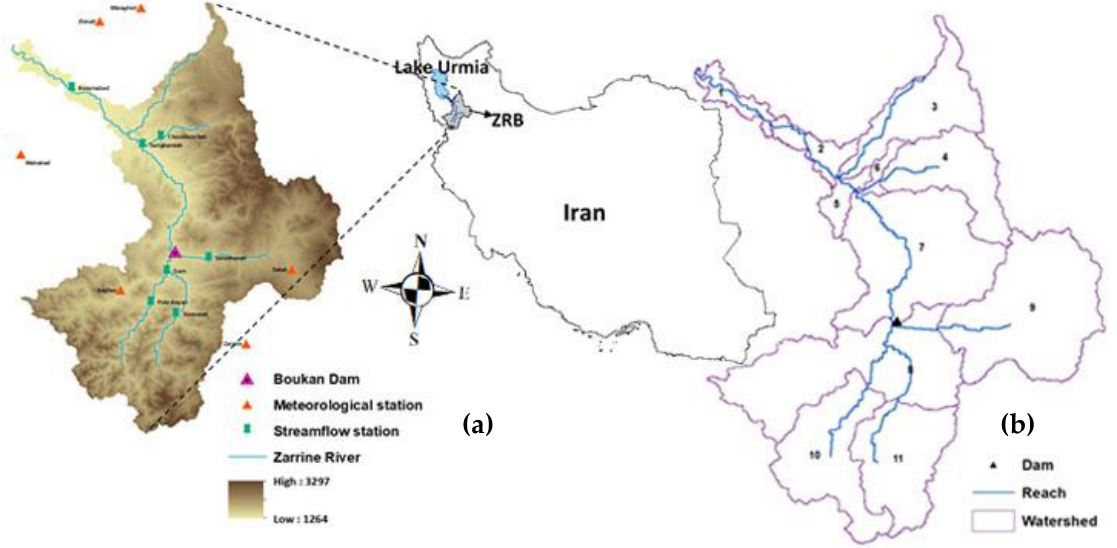
Figure 1. Map of the Zarrine River basin (ZRB) in northwestern Iran with the Boukan Dam and the climate and streamflow stations ( a ), together with the basin configuration of the Soil and Water Assessment Tool (SWAT) model ( b ).